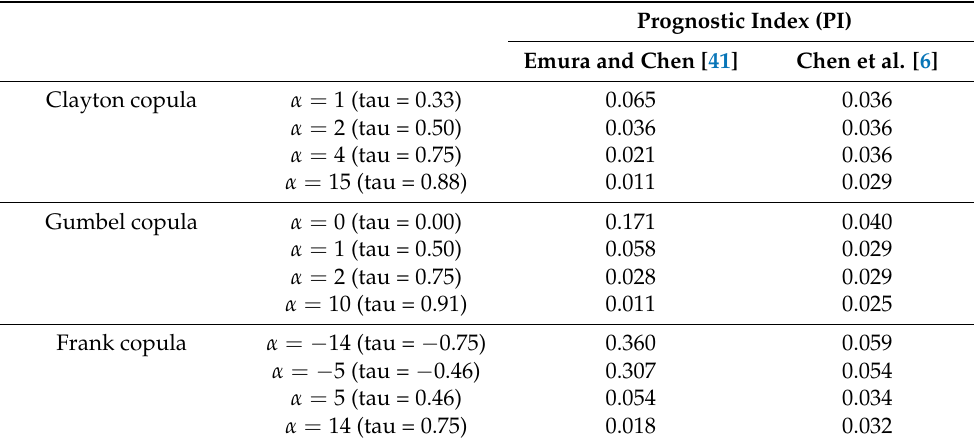
Table 1. p -values for testing the difference of survival prognosis (good vs. poor) under the three copulas with selected values of α (Kendall’s tau takes − 0.75, − 0.46, 0, 0.33, 0.46, 0.50, 0.75). Prognostic Index (PI) Emura and Chen [41] Chen et al. [6] Clayton